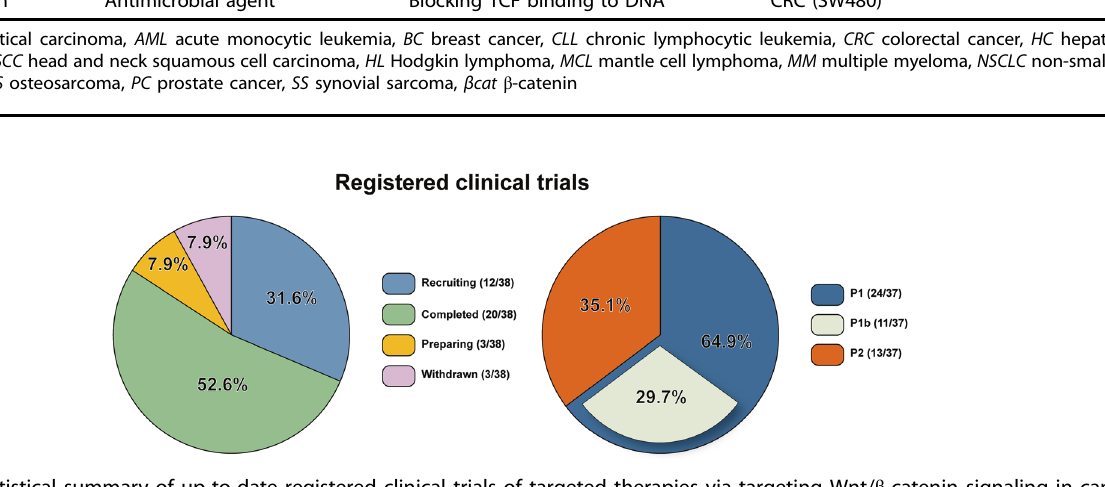
Fig. 5 The statistical summary of up-to-date registered clinical trials of targeted therapies via targeting Wnt/ β -catenin signaling in cancers. The left panel indicated the stages and the right one showed the phases of clinical trials. P1 phase I, P1b phase IB, P2 phase 2. All clinical trials included were updated until May